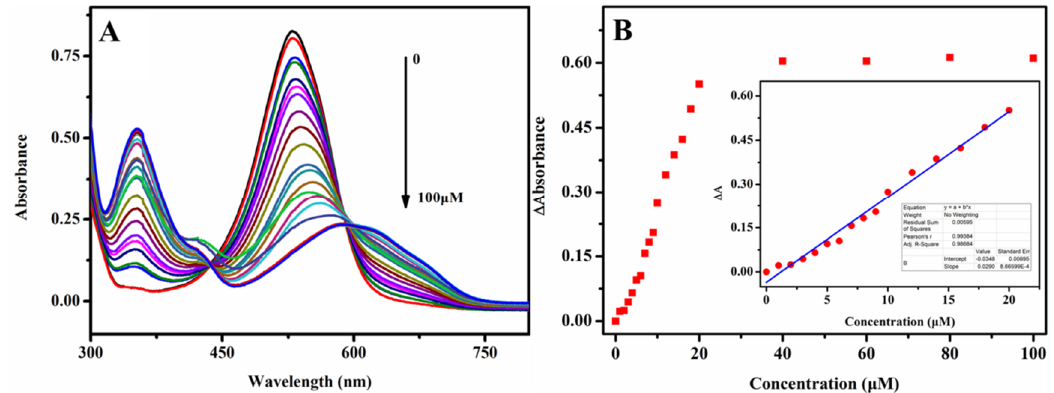
− with 2 − concentrations 2